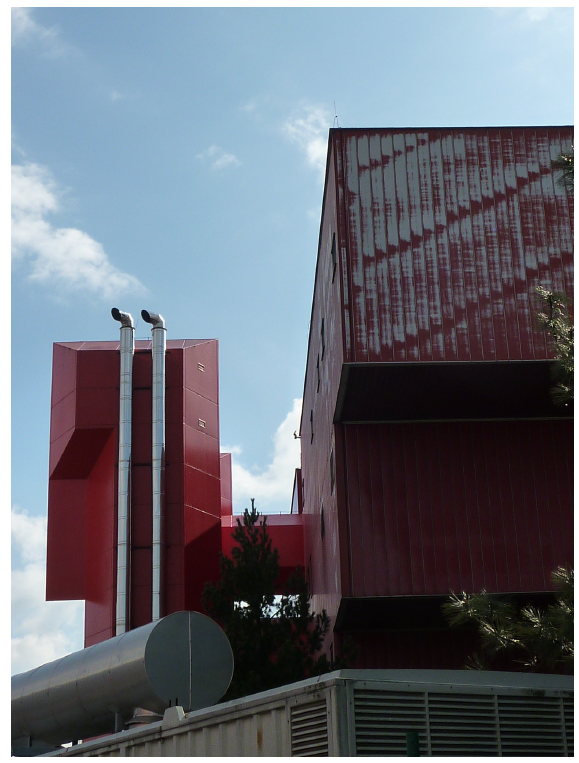
Figure 4. Telecommunications building in Hradec